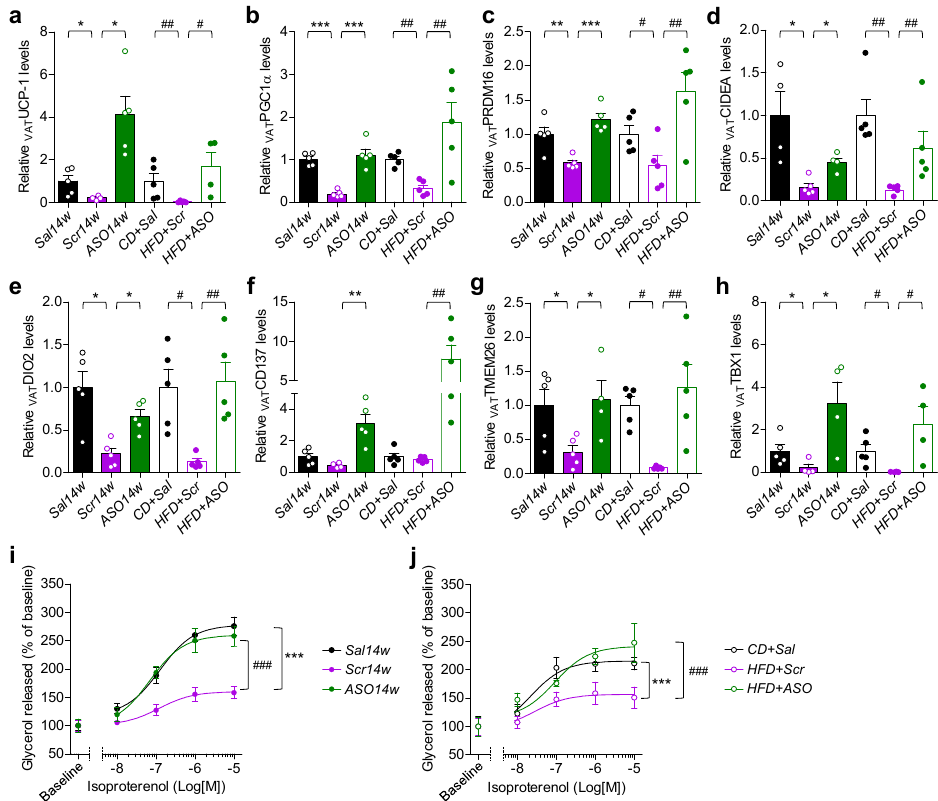
Figure 4. Increase in thermogenic and beiging gene markers by apoCIII reduction improves catecholamine-induced lipolysis in VAT. ( a – h ) Expression of ( a ) UCP - 1 , ( b ) PGC1 α , ( c ) PRDM16, ( d ) CIDEA , ( e ) CD137 , ( d ) TMEM26 and ( d ) TBX1 mRNA in the prevention (filled bars) and reversibility (empty bars) studies. ( i , j ) Concentration–response curves of isoproterenol-induced lipolysis in isolated adipocytes from VAT from ( i ) the prevention and ( j ) reversibility studies. Data expressed as mean ± SEM of n = 4–5 individual mice per experimental group and controls. * p < 0.05; ** p < 0.01; *** p < 0.001 for differences in the prevention study. # p < 0.05; ## p < 0.001; ### p < 0.001 for differences in the reversibility study.